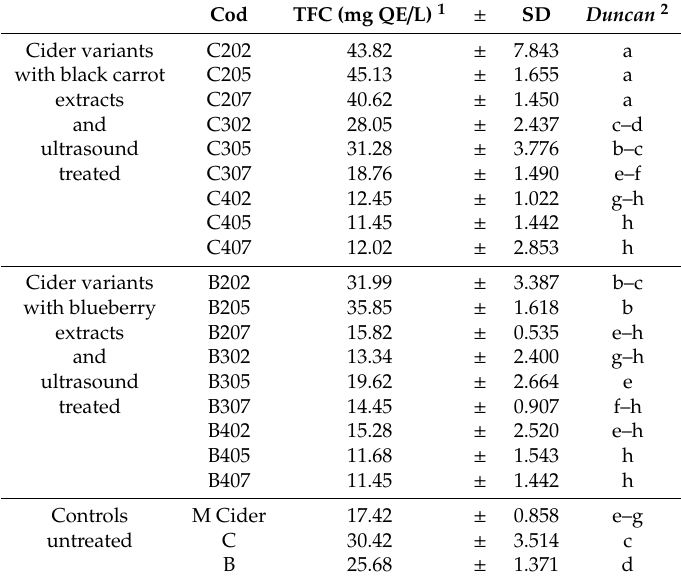
Table 4. Flavonoid contents of the cider experimental variants.